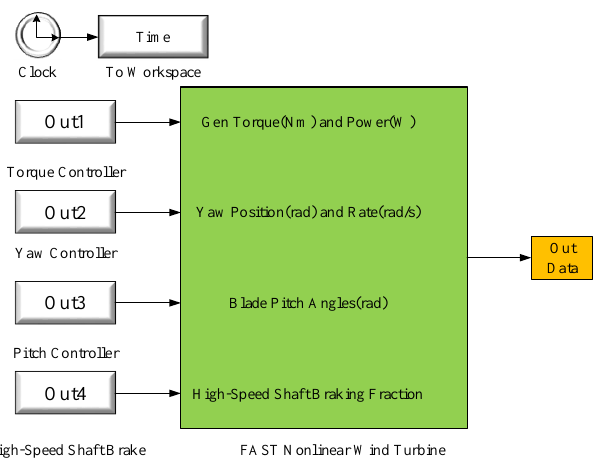
Figure 1. FAST Simulink S-function.